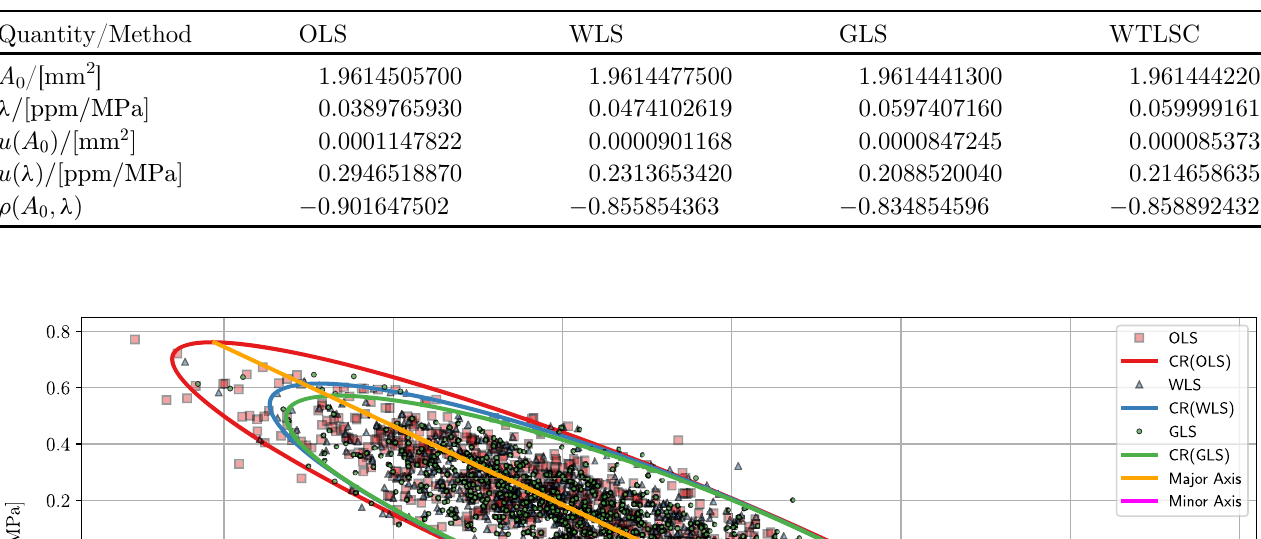
Table 2. Final results and comparison of numerical experiments using the WTLSC, OLS, WLS, and GLS methods.